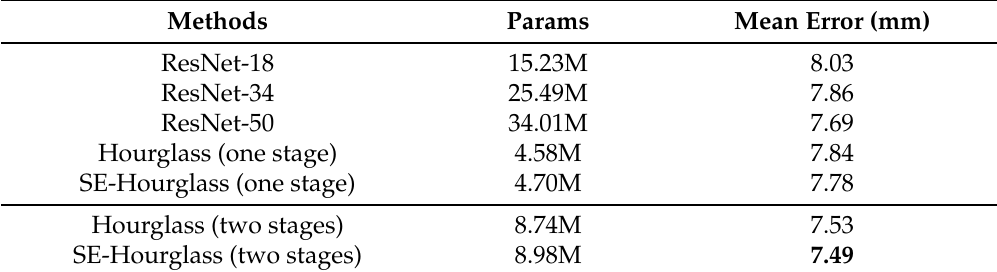
Table 4. Comparison of different backbone networks.